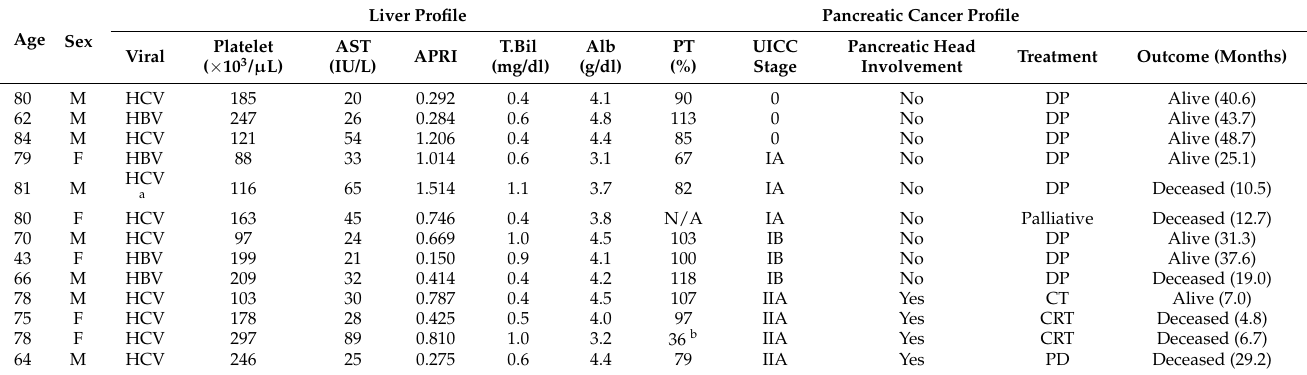
Table 3. Profile of the PC patients indicated for surgical resection in the HCC surveillance